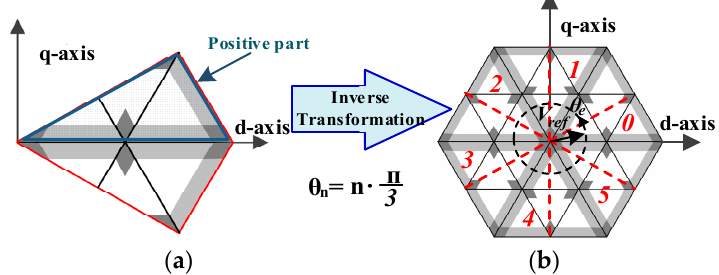
Figure 17. Inverse transformation shifted sector. ( a ) Shifted sector (0); ( b ) shifted sectors (0–5).